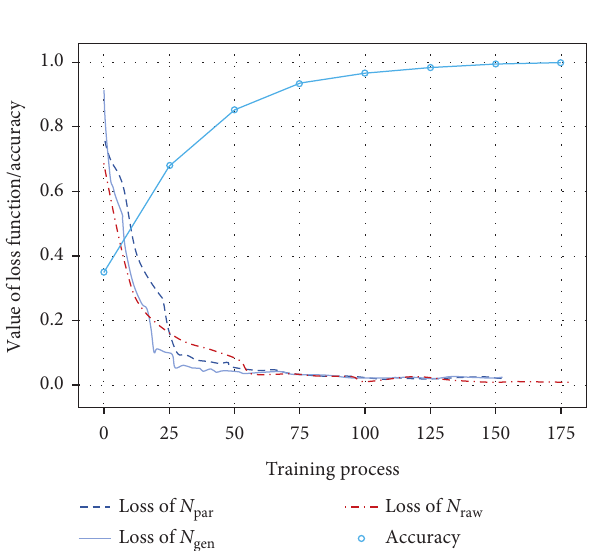
Figure 7: The values of loss functions and accuracy vary with the training process of three neural networks.